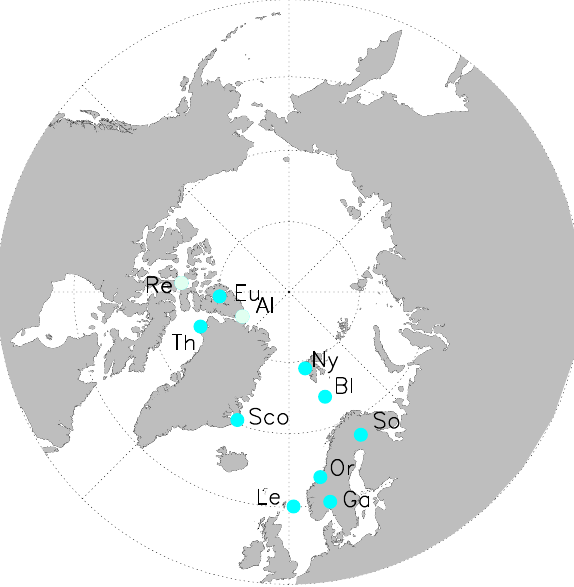
Figure 1. Geographical positions of the ozonesonde stations: Eu- reka (Eu), Ny Ålesund (Ny), Thule (Th), Bear Island (BI), Scores- bysund (Sco), Sodankylä (So), Ørland (Or), Gardermoen (Ga), Ler- wick (Le). Also, Resolute (Re) and Alert (Al) are